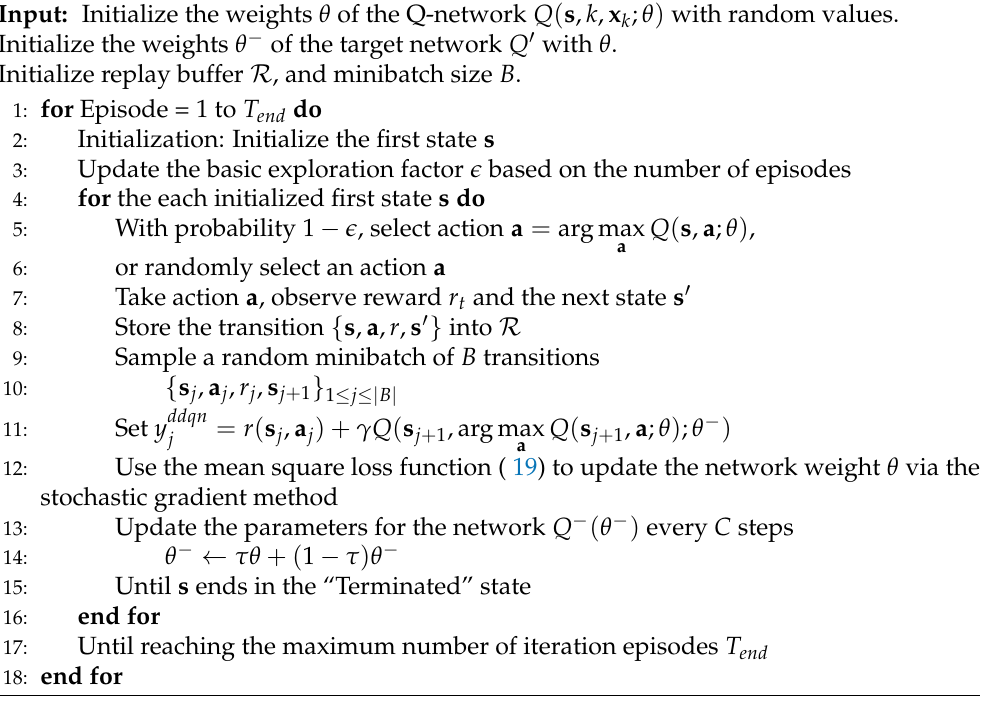
Algorithm 1 The Training of the DDQN Algorithm in